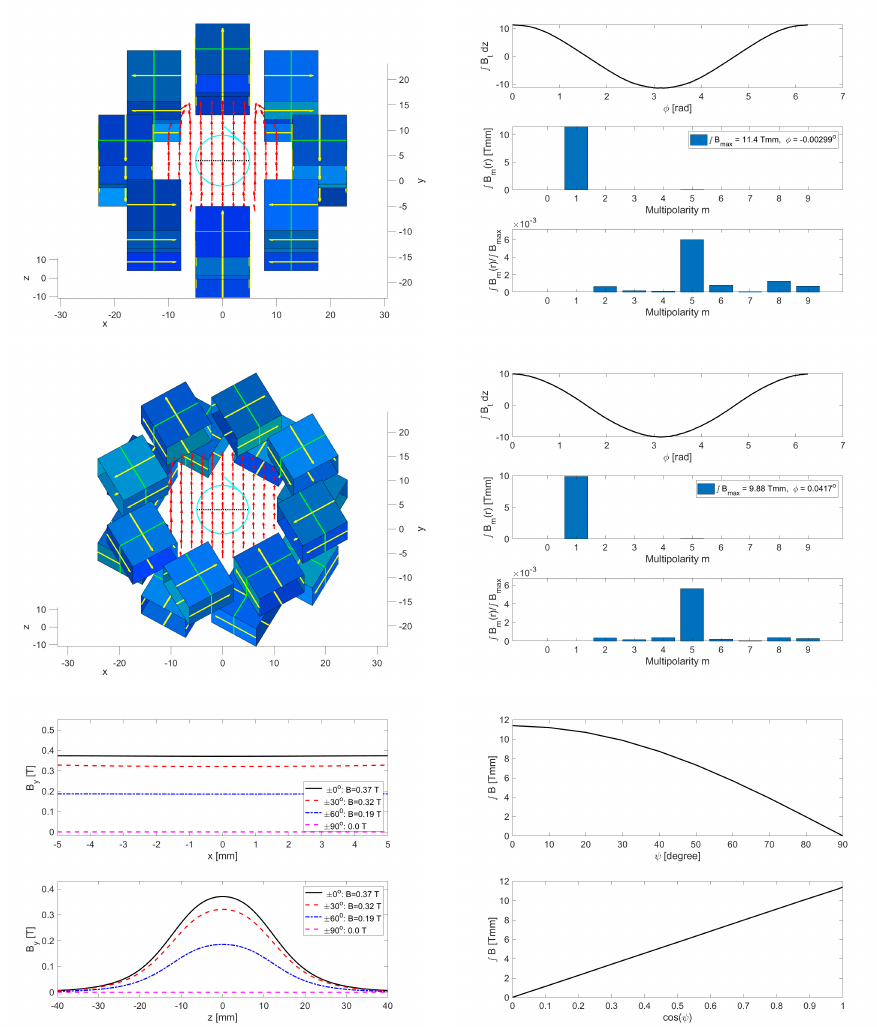
Figure 6. Top left: two rings for a variable dipole aligned on top of each other. Top right: the tangential field on the cyan circle (upper), the dominant field harmonic (middle), and the relative strength of the unwanted harmonics (bottom). Middle row: the corresponding images for rings rotated with ψ = 30 ◦ . The integrated strength was reduced, but the unwanted harmonics were similar to the plot above. Bottom left: the fields along the black dotted line for different rotation angles ψ (upper) and B y along a line through the center of the two rings. Bottom right: the integrated field plotted versus ψ (upper) and cos ψ